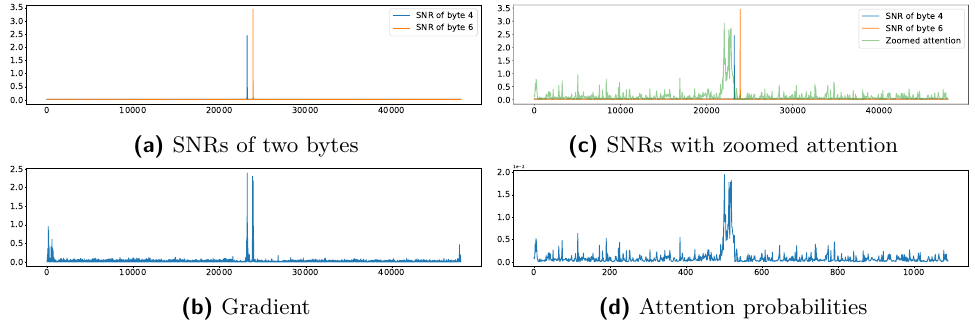
Figure 18: Results of SNRs, gradient and attention for a network trained on AT128-N.